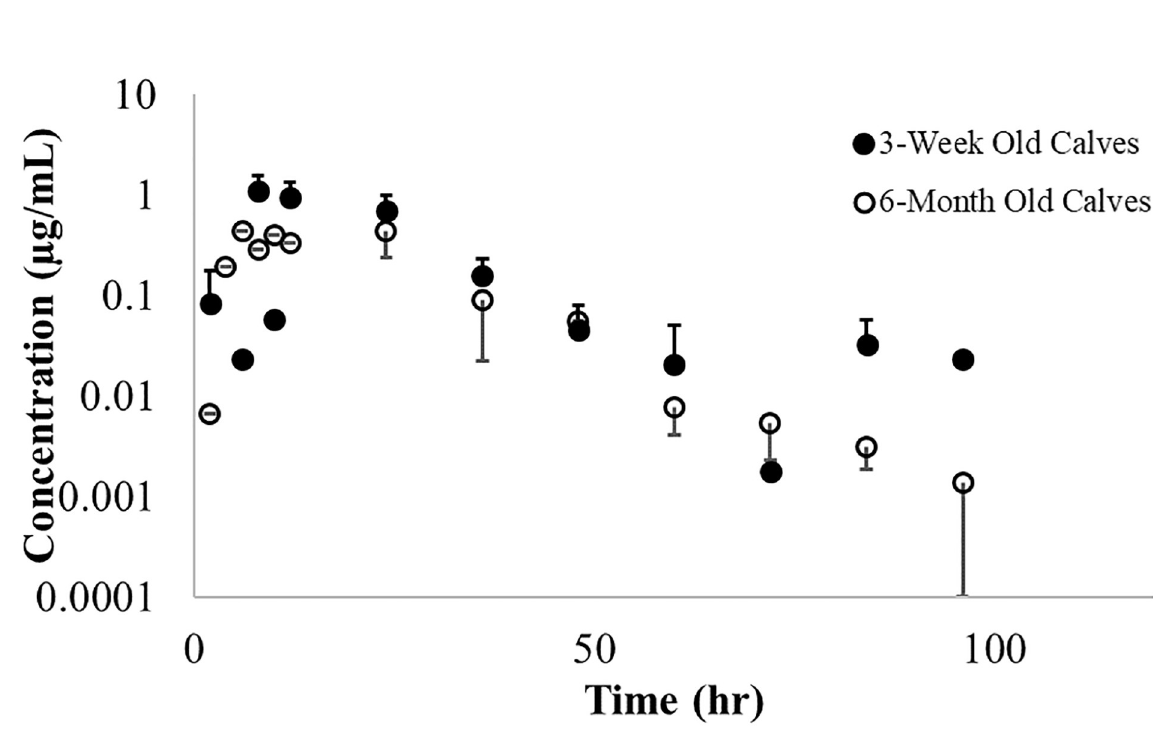
Fig 3. Mean interstitial fluid ± SD concentrations of danofloxacin. Danofloxacin was administered via single S.C. injection of 8 mg/kg danofloxacin in 3-week old (solid circles) and 6-month old calves (open circles).